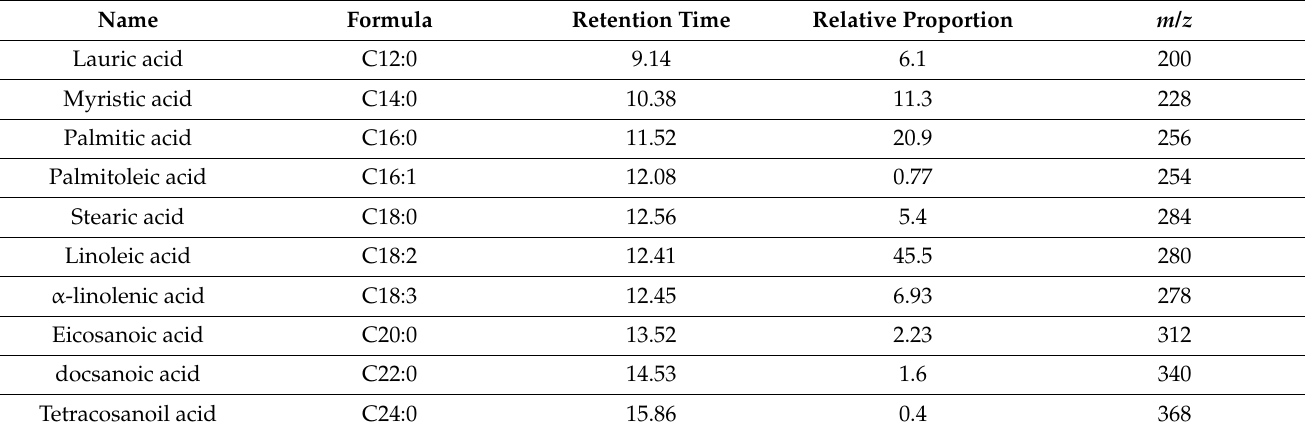
Table 1. GCMS for the gorse flower fatty acids.